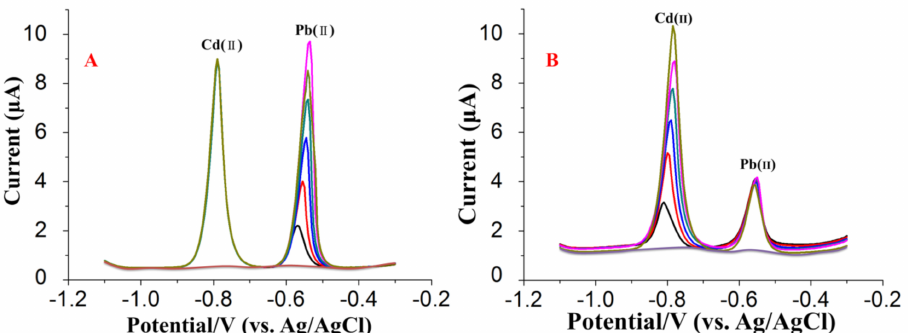
Figure 7. SWASV curves at (BiO) 2 CO 3 -rGO-Nafion / GCE in 0.2 M acetate bu ff er solution (pH 5.0) containing ( A ) di ff erent concentrations of Pb(II) in the presence of 40 µ g / L Cd(II), ( B ) di ff erent concentrations of Cd(II) in the presence of 25 µ g / L